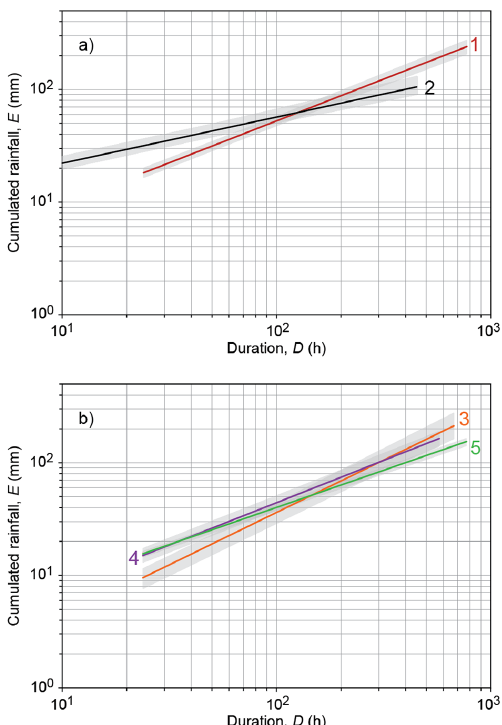
Figure 7. (a) Cumulated event rainfall–rainfall duration (ED) 5% thresholds for rainfall-induced landslides in Calabria defined in this study ( T 5 , Cal , 1), compared to the 5% threshold for shallow land- slides in Calabria defined in Vennari et al. (2014) ( T 5 , Ven , 2). (b) Cumulated event rainfall–rainfall duration (ED) 5% thresholds de- fined for the three 30-year periods 1921–1950 ( T 5 , 21 − 50 , 3), 1951– 1980 ( T 5 , 51 − 80 , 4), and 1951–2010 ( T 5 , 81 − 10 , 5). Grey areas show uncertainties associated to the thresholds. Data shown in log-log